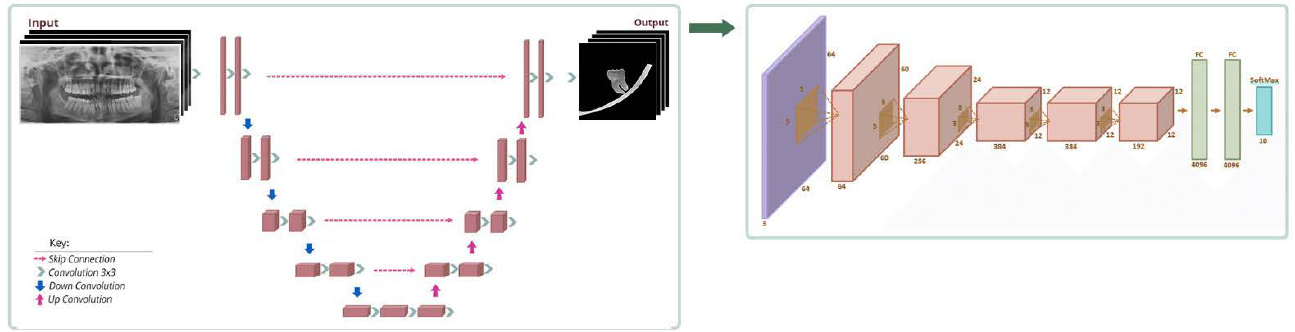
Figure 2. The workflow for the segmentation and the classification processes of mandibular third molar and mandibular canal. The first schema represents the encoder-decoder style network of U-Net. The output of this network feeds the AlexNet architecture which is seen in the second diagram.